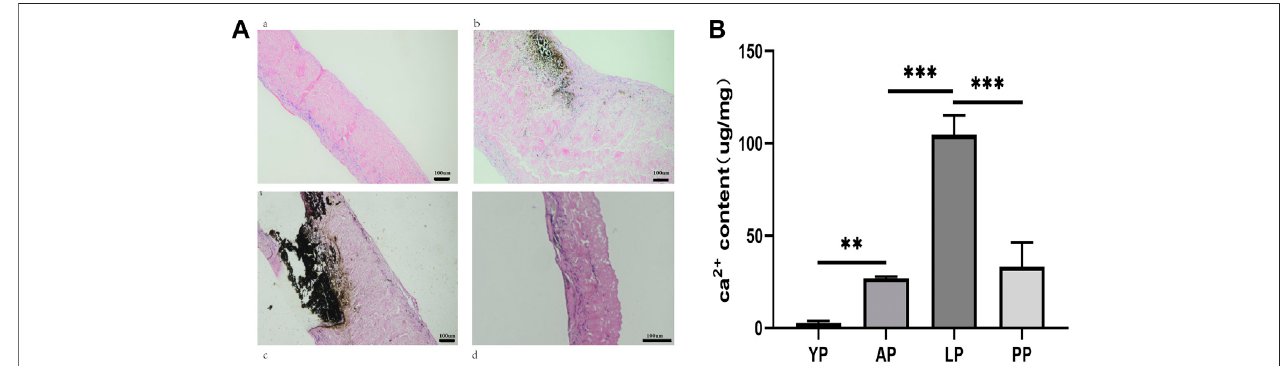
FIGURE 14 | In vivo anti-calci fi cation assay of GA-YP, GA-AP, GA-LP and GA-PP after subcutaneous implantation for 8 weeks ( n (cid:2) 5 for each group) (A) , Von Kossa staining after implantation for 8 weeks. (B) , Ca2+ content in the implantation was calculated. scale bars are 100 um.